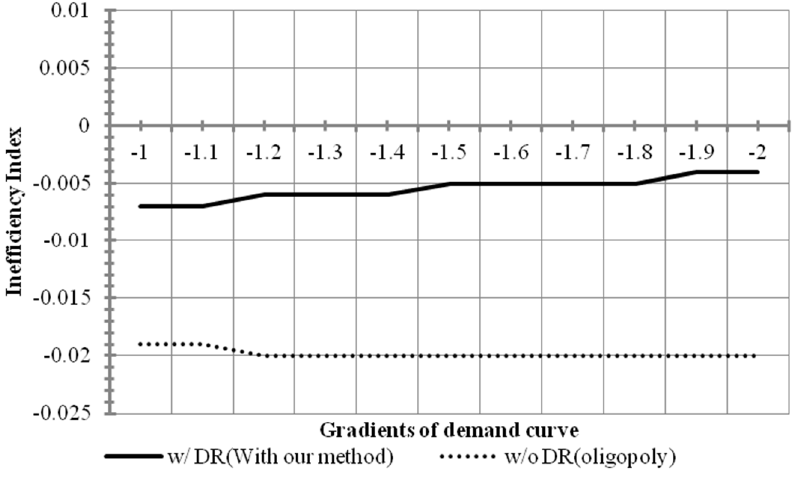
Figure 9. The inefficiency index with the three methods as a function of the gradient of the demand